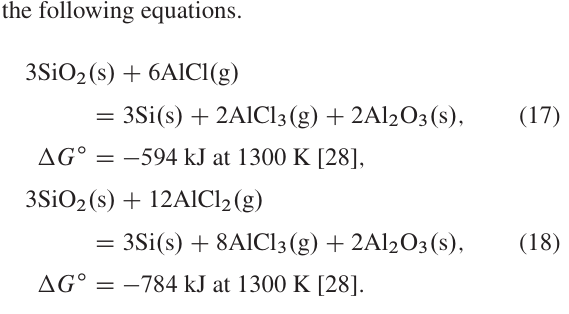
which AlCl was preferentially produced over AlCl 2 . The reaction rate for AlCl x formation ranged from 10 (cid:3) 5 to between halidothermic reduction and aluminothermic re- duction was verified by Al deposition experiments and